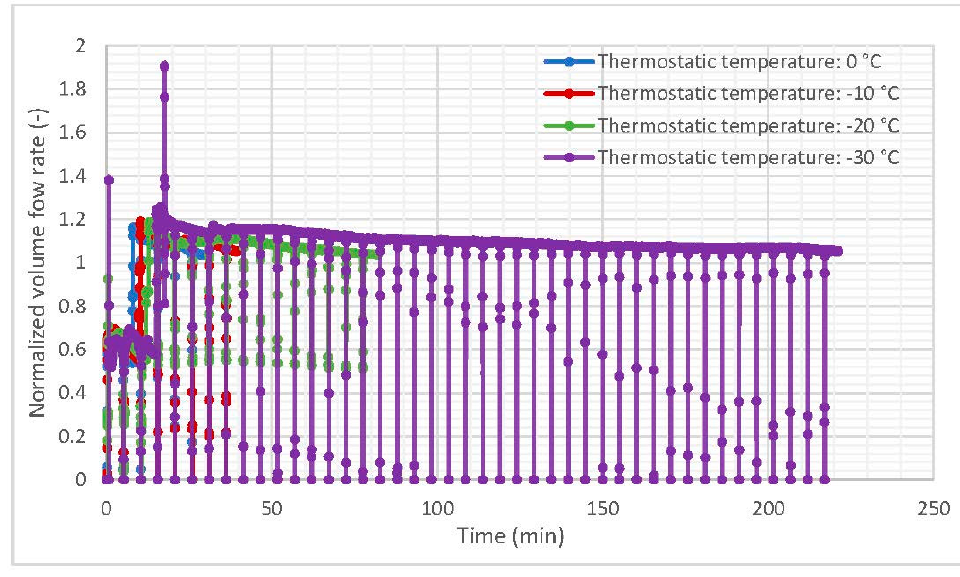
Figure 5. Normalized volume flow rate averaged over the two tests executed for the diverse thermo- static temperatures.